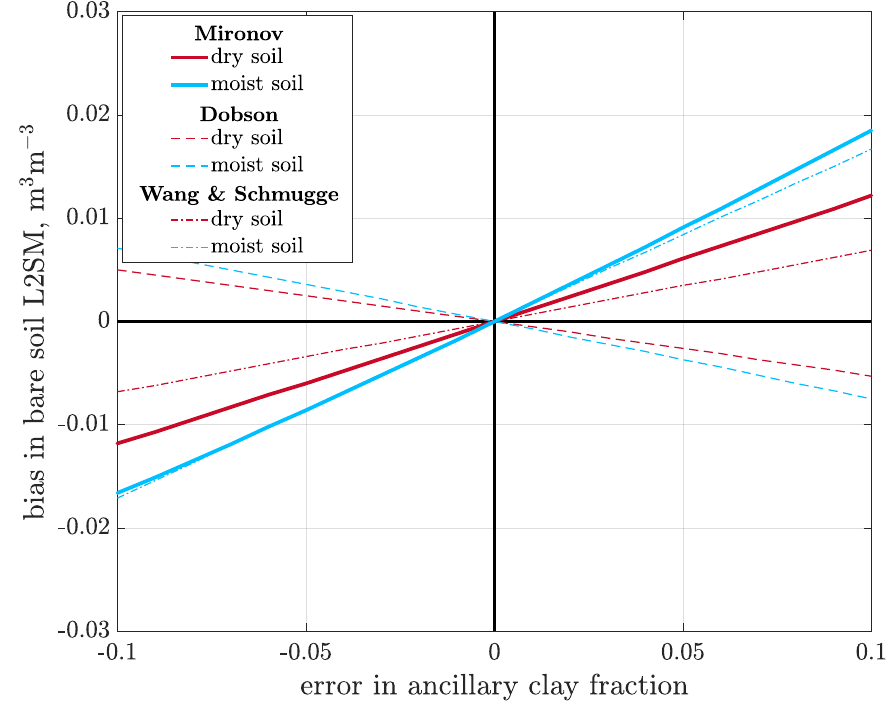
Figure 9. Sensitivity of L2SM retrieval to over- and under-estimation of clay fraction ( + and − errors, respectively) for bare soil utilizing the Mironov, Dobson, and Wang and Schmugge dielectric mixing models to simulate (cid:101) r . Both dry (0.10m 3 m − 3 ) and moist (0.25m 3 m − 3 ) soils with a temperature of 300K are included.